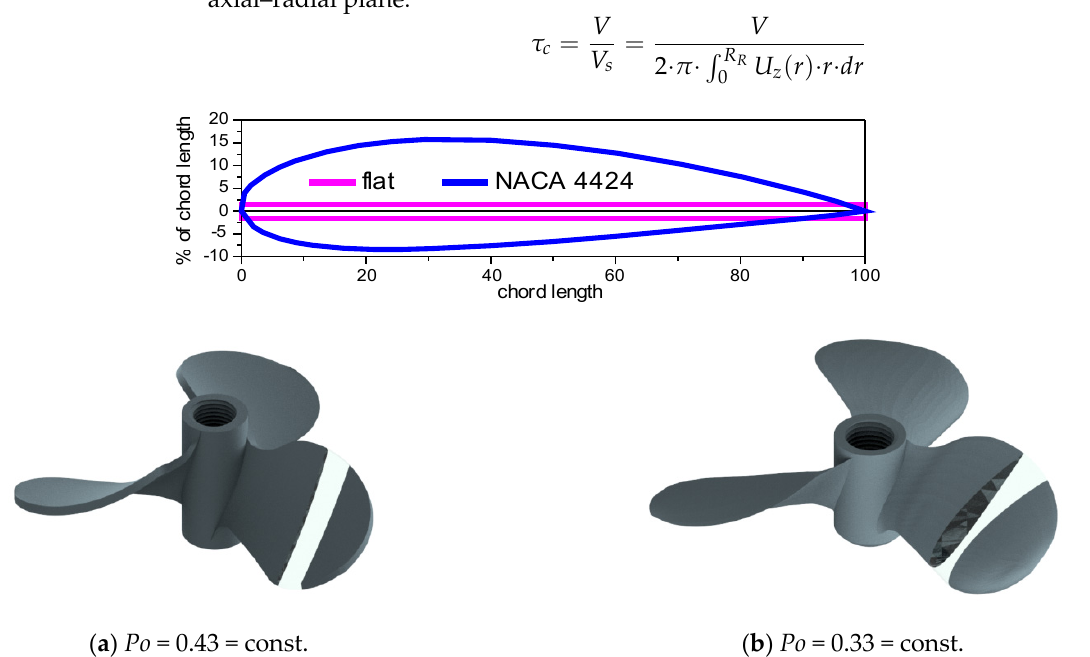
Figure 1. Propellers and powers numbers. ( a ) with flat cross ‐ section. ( b ) with NACA4424 cross ‐ section [2].